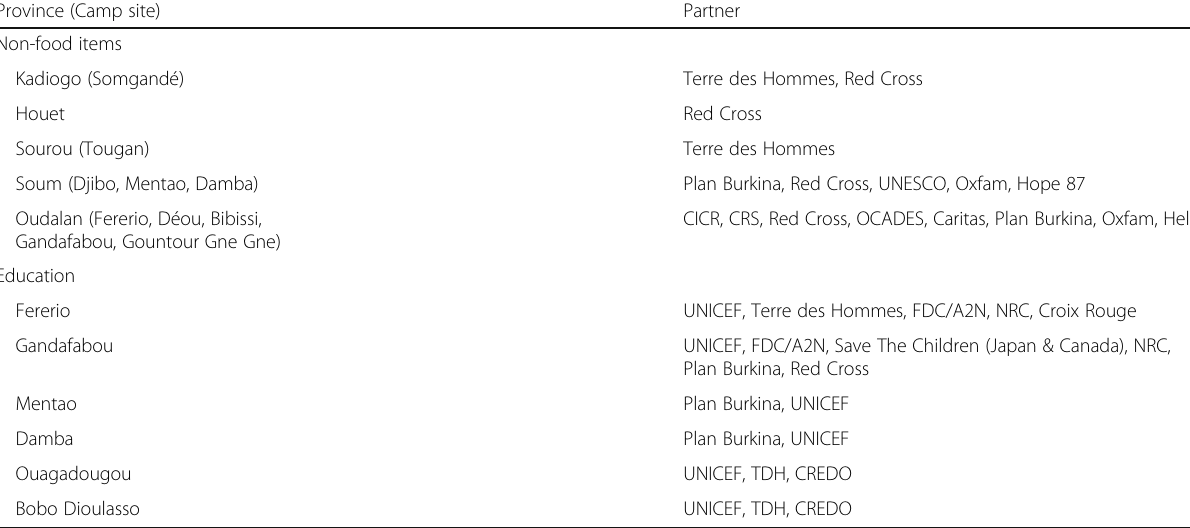
Table 2 Example of the numerosity of actors with the same expertise per camp Province (Camp